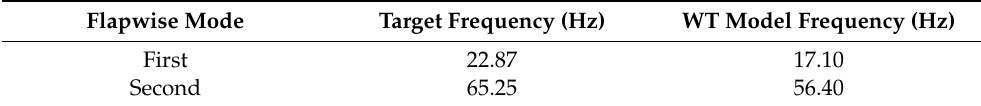
Table 5. Comparison between the frequency of the first flapwise mode for the DTU 10 MW (target) and the 1:75 wind tunnel scale model (frequencies are reported at the model